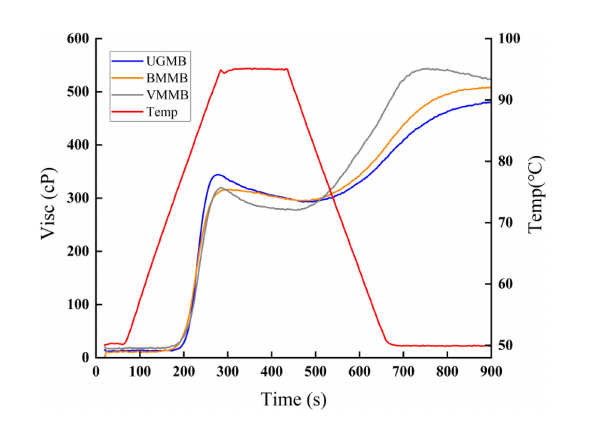
FIGURE 4 Viscosity curve of mung bean flour.